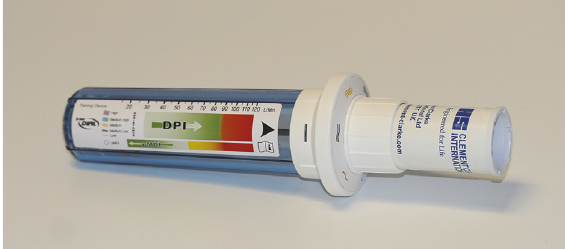
Figure 1: In-Check DIAL G16 (Clement Clarke International Lim- ited). In-Check DIAL G16 is a multipatient clinic/pharmacy device using disposable, single-patient mouthpieces and is used for assess- ing the inspiratory effort of a patient inhaling through a selected inhaler.TheDIALcanbesettoresembletheresistanceoftheinhaler, and the appropriate inhalation—slow and gentle for pMDI and fast and strong for DPI—can be coached. See online animation: https:// www.youtube.com/watch?v=bGCfCGw9